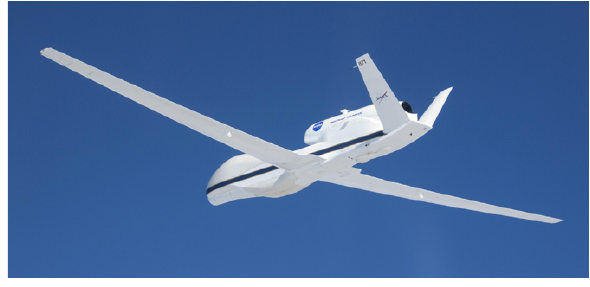
Figure 8. Global Hawk UAS